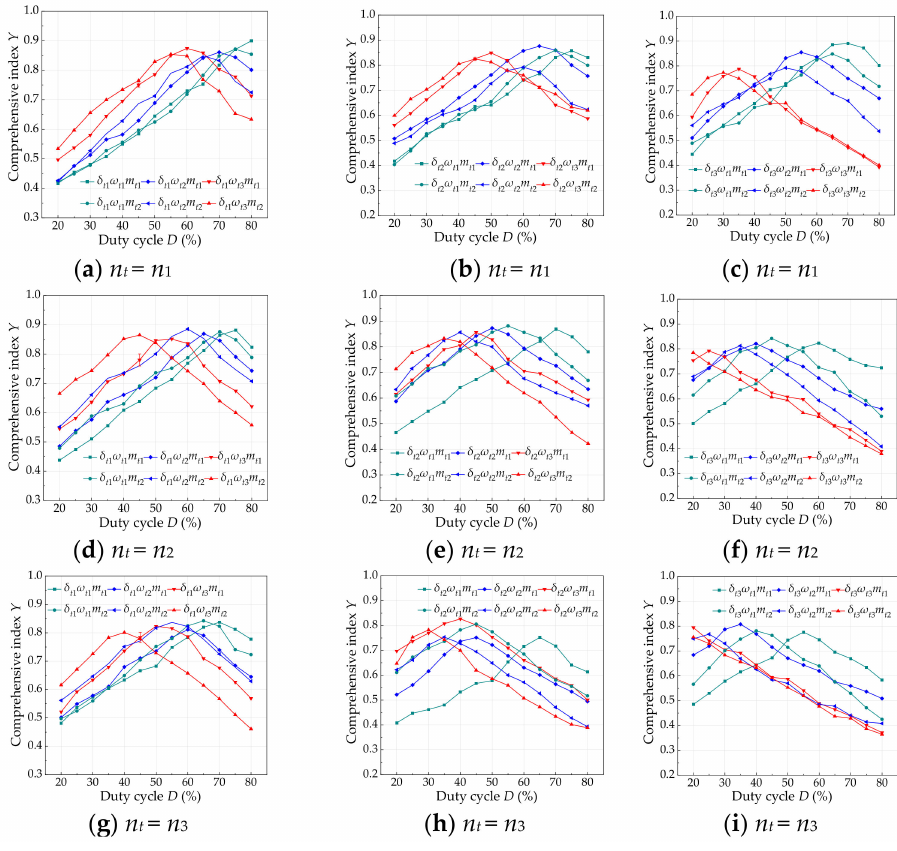
Figure 6. Effect of duty cycle on comprehensive index under different conditions.